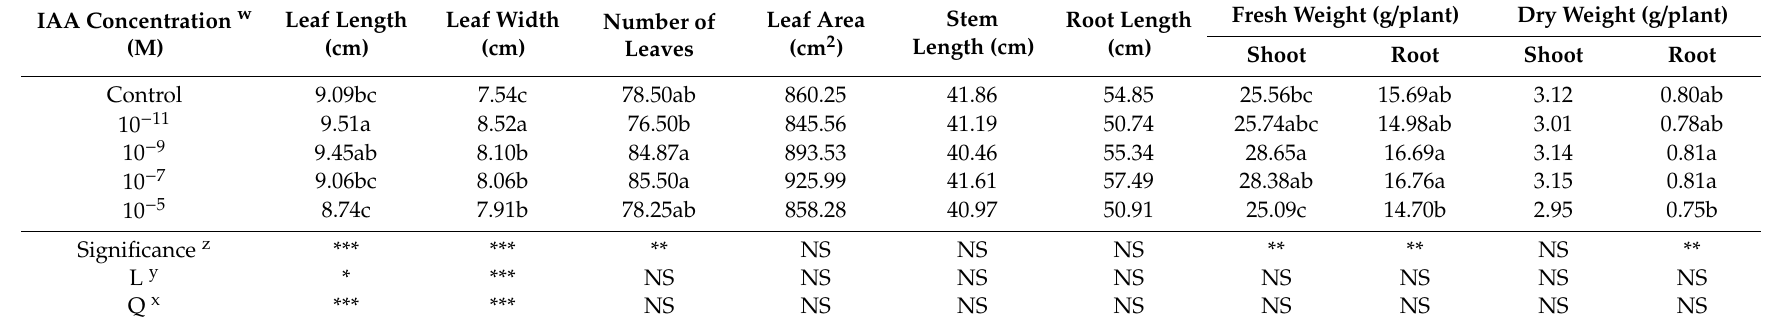
Table 1. Plant growth parameters of Agastache rugosa subjected to the control (without IAA) and four IAA